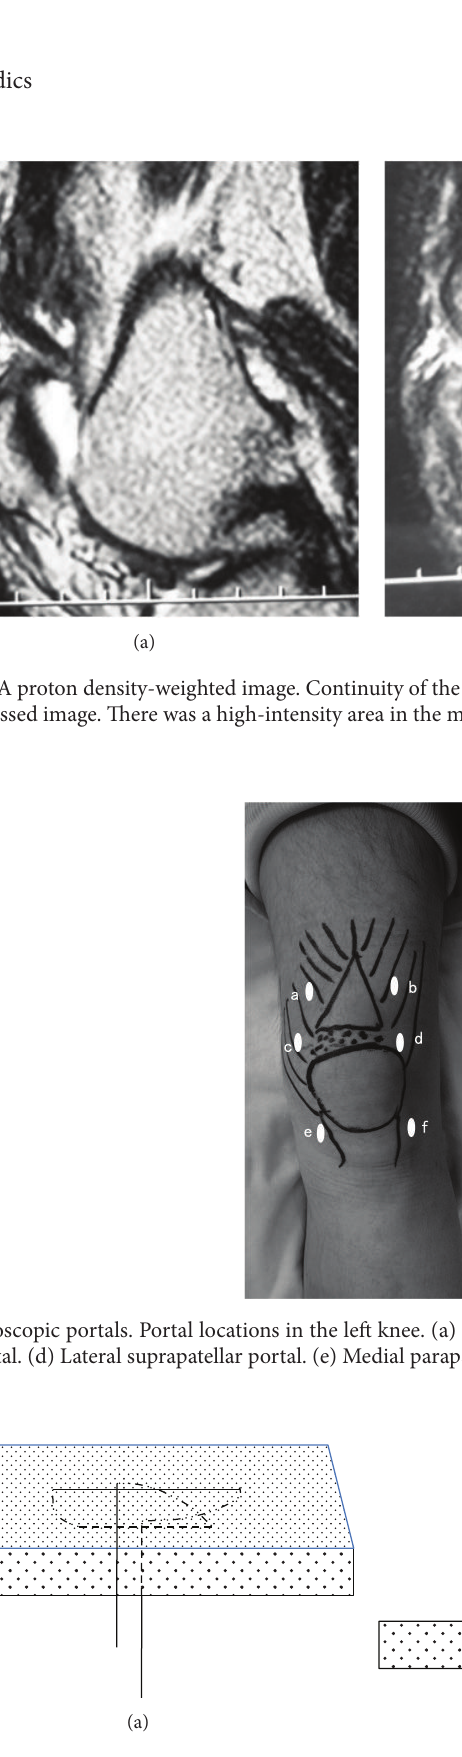
Figure 5: Schema of modified Mason–Allen